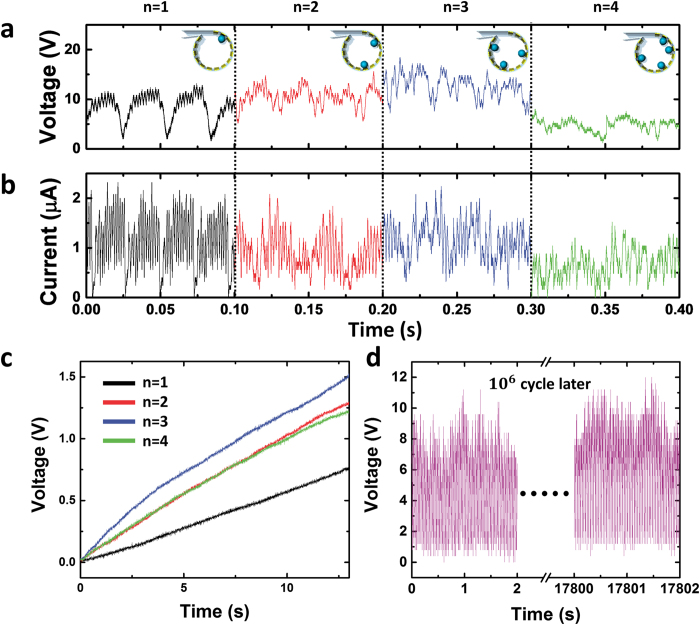
Electrical power output of the WR-TENG based on the number of EPS spheres and the durability of the WR-TENG.The (a) VOC, and ICC outputs of the WR-TENG based on the number of EPS spheres inside the vortex whistle. (c) A 100 μF capacitor charging rate depending on number of spheres inside. (d) The durability test (>106 cycle) results for the WR-TENG.